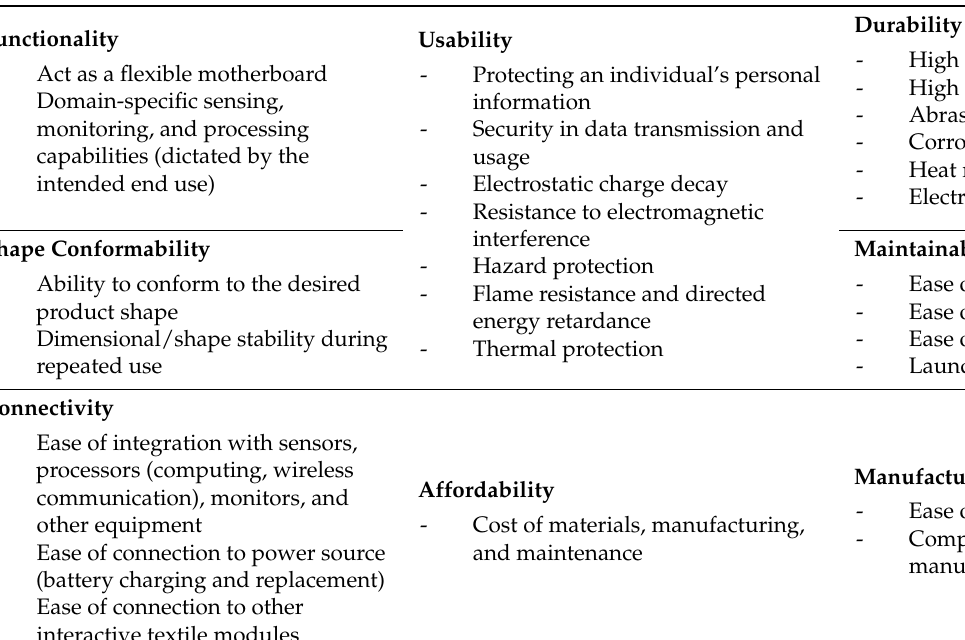
Table 1. Performance requirements for interactive